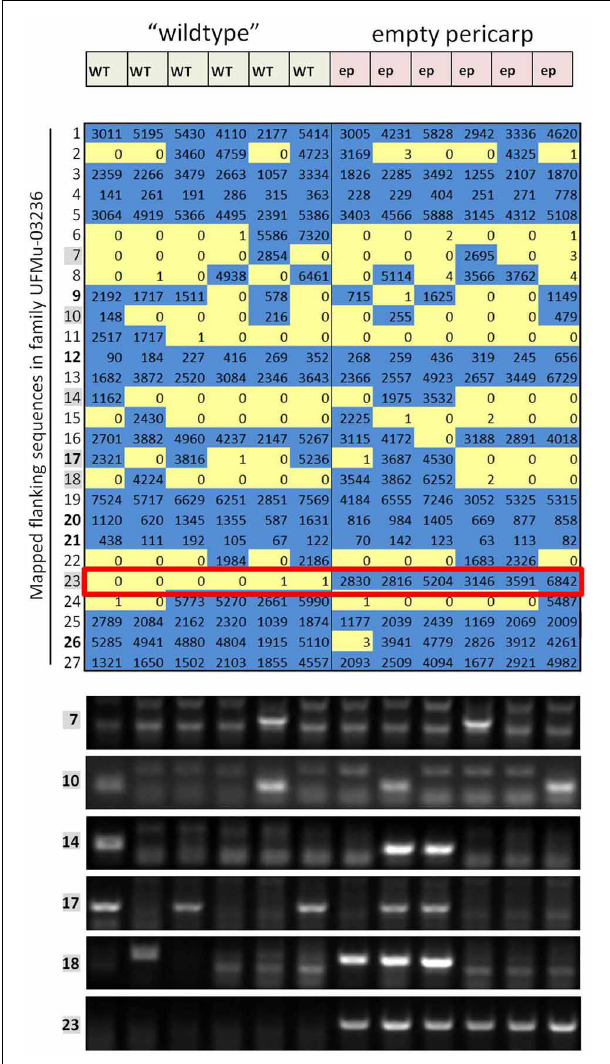
FIGURE 2 | Expanded results for one of the families in the forward-genetics Mu-seq grid. Sequencing reads obtained for pool-7, corresponding to family UFMu-03236, are organized here based on insertion site (chromosome and location) and compared to phenotypic data to test co-segregation. In this example, normal ears made up the left half of the grid (pools A through F) and mutant ears were arranged on the right side of the grid (pools G through L, see Figure 1B ). Of the 27 flanking sequences identified in pool 7 (assigned to family UFMu-03236), only number 23 showed co-segregation with the empty-pericarp phenotype (outlined in red). To check the consistency and reliability of the sequencing approach, including assignment of map locations, DNA from the individual plants included in the grid for this family was analyzed by PCR for the presence/absence of six of the segregating insertions (indicated by gray boxes). Results were consistent for PCR and